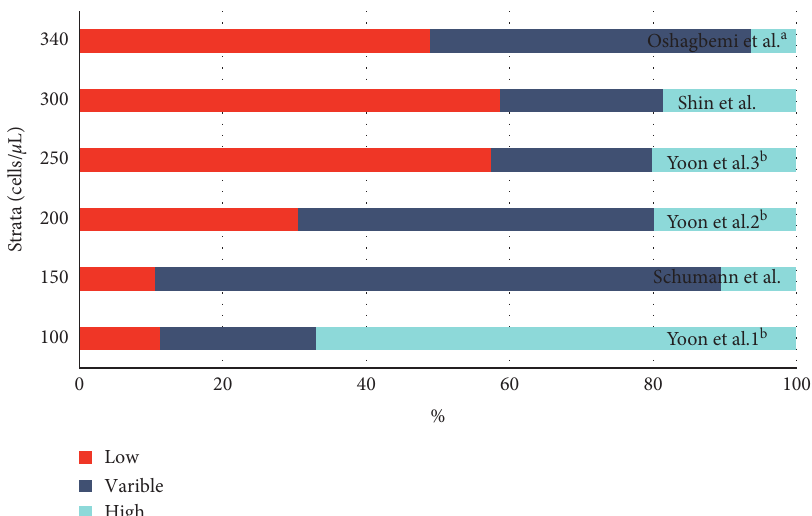
Figure 2: Distribution of BEC level with various strata from different studies. a The data were recalculated based on the original data with longest observation time. b The data were obtained from the same study with different strata levels. Distribution of BEC level at the cut-off value of 150cells ( μ L)